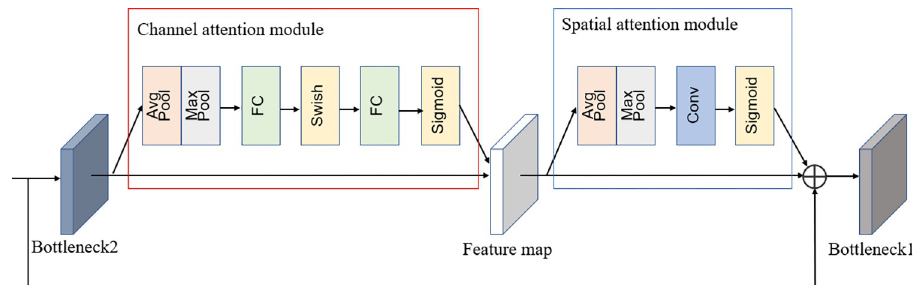
Fig 5. The CBAM structure used in the model.